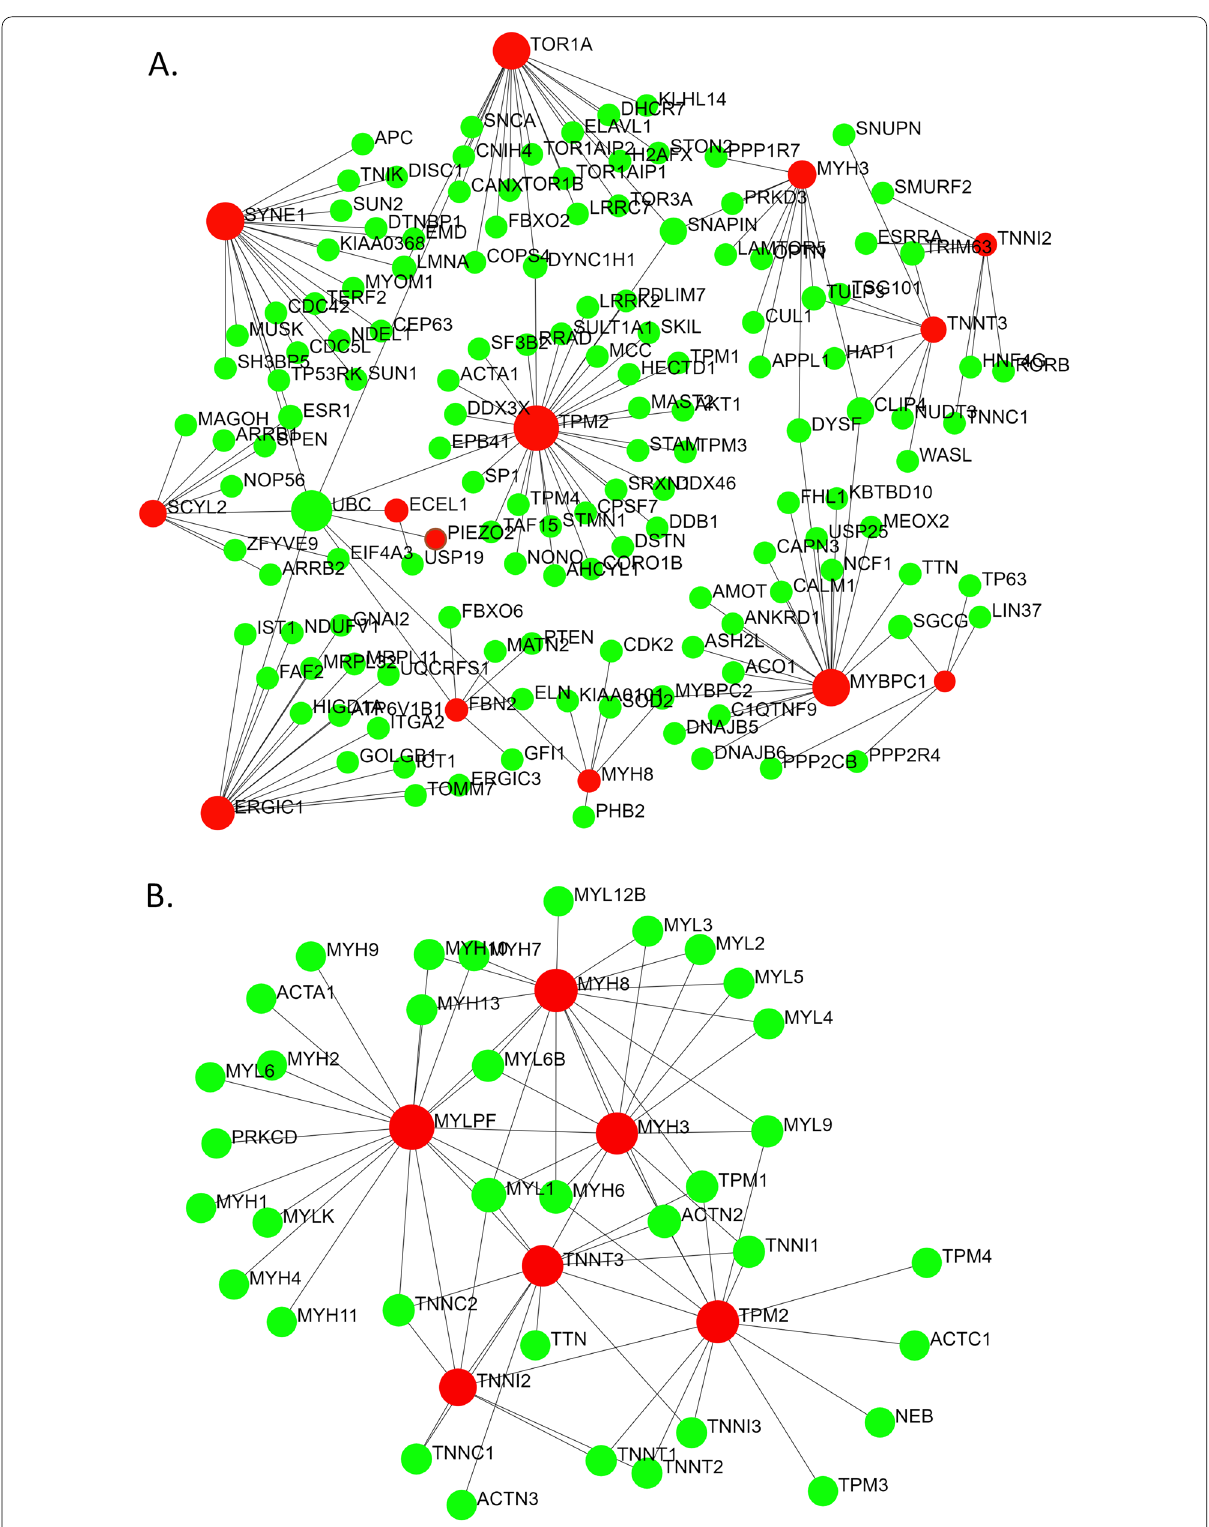
Fig. 1 PPI networks generated using 15 known genes associated with AMCs and DAs based on ( A) IMEx and ( B) STRING databases. AMC and DA-associated gene-encoded proteins are shown in red and the other interacting proteins are shown in